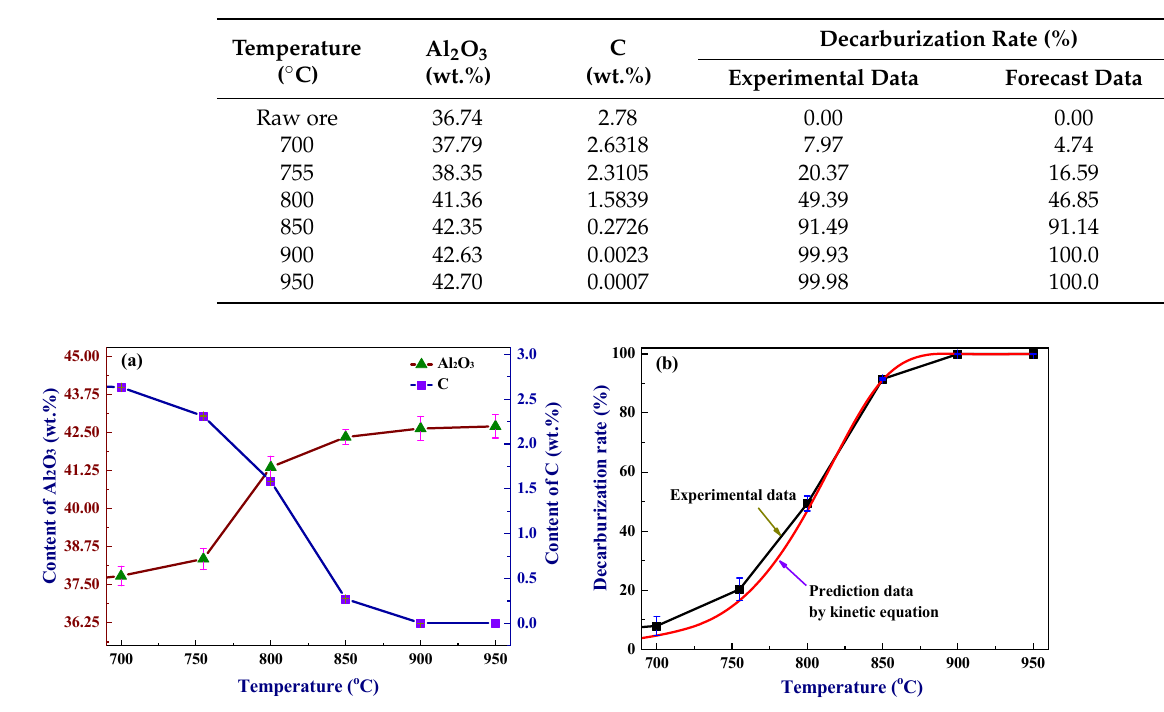
Figure 8. Graph of ( a ) carbon content and ( b ) decarburization rate of calcined kaolin.